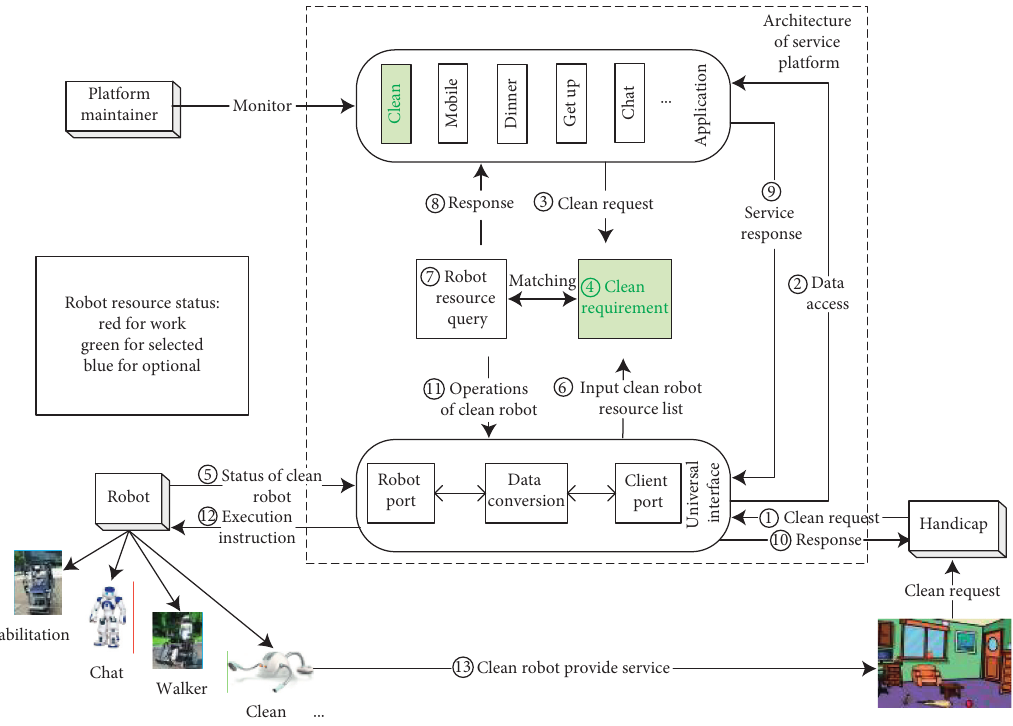
Figure 3: The workflow case of response for clean request in